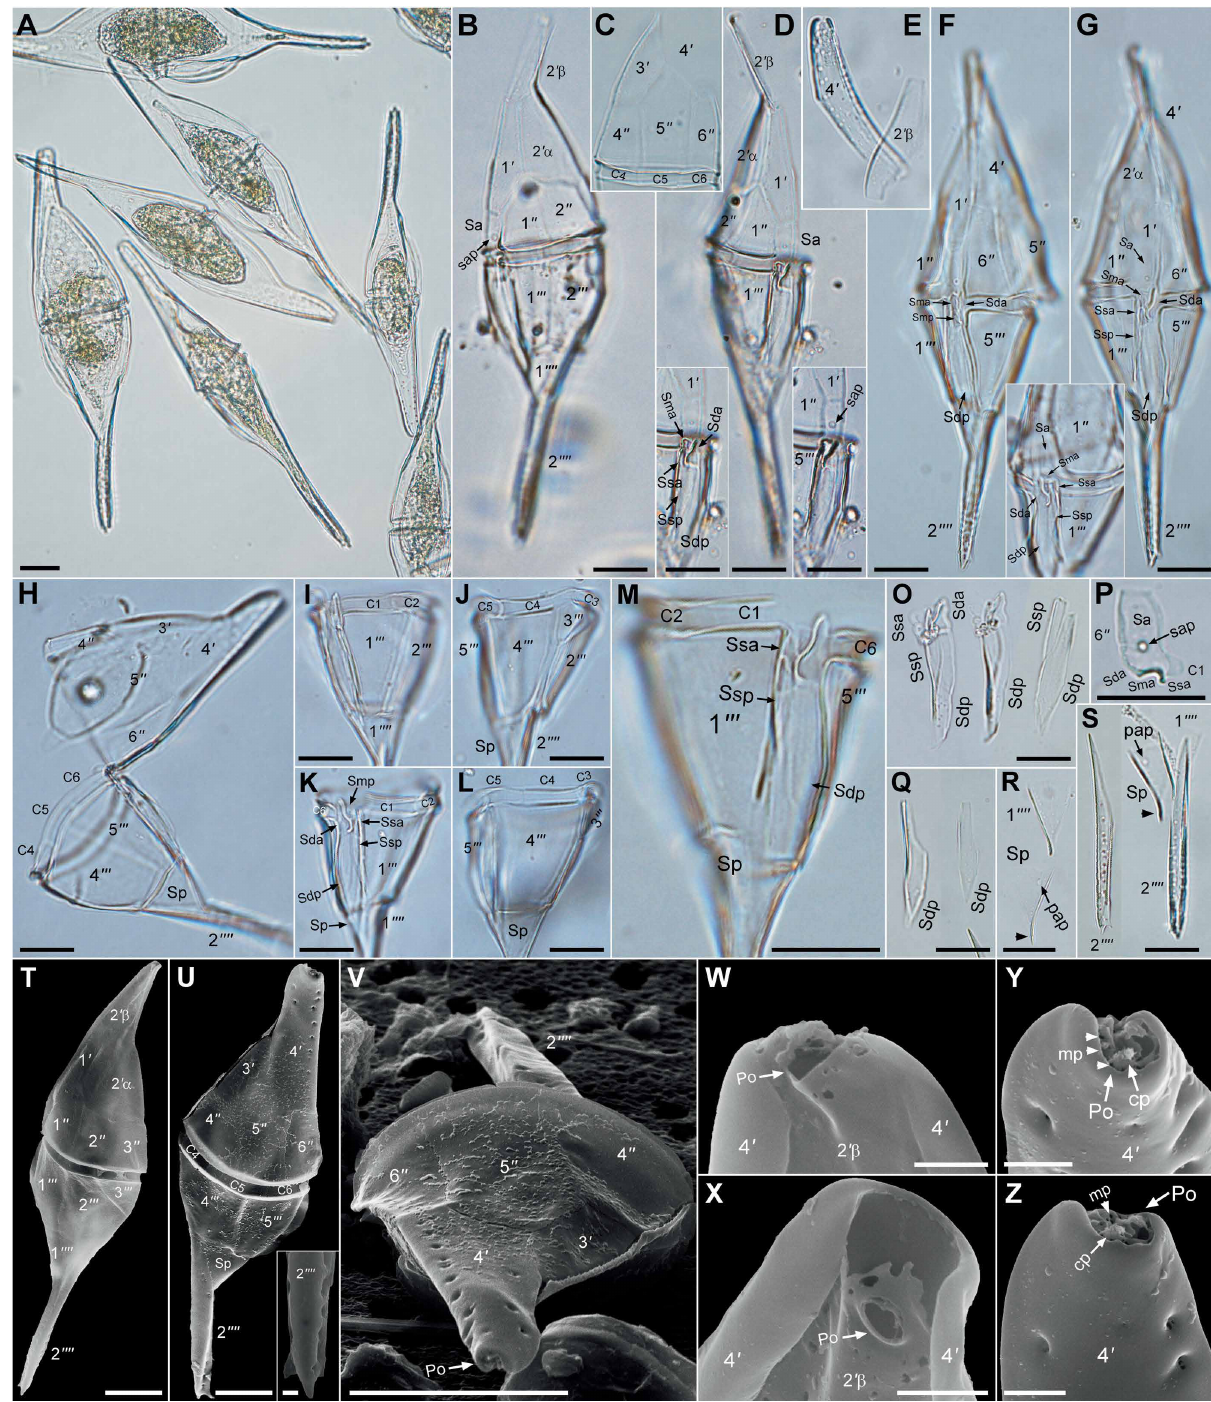
Figure 3: Light (a–s) and scanning electron (t–z) micrographs of Centrodinium eminens . (a) Several individuals. (b) Left face. (c) Right epitheca. (d) Left-ventral view. The insets show the sulcus. (e) Dissociated plates of the apical horn. (f–g). Ventral views. The inset shows the sulcus. (h) Dissociated epitheca and hypotheca. (i–m) Several views of the same epitheca. (o, q) Dissociated posterior lateral sulcal plates. (p) Anterior sulcal. (r) Posterior sulcal and first antapical plate. The arrowhead points a filiform extension. (s) Antapical horn. (t) Left face. (u–v) Right face. (w–z) Apex.